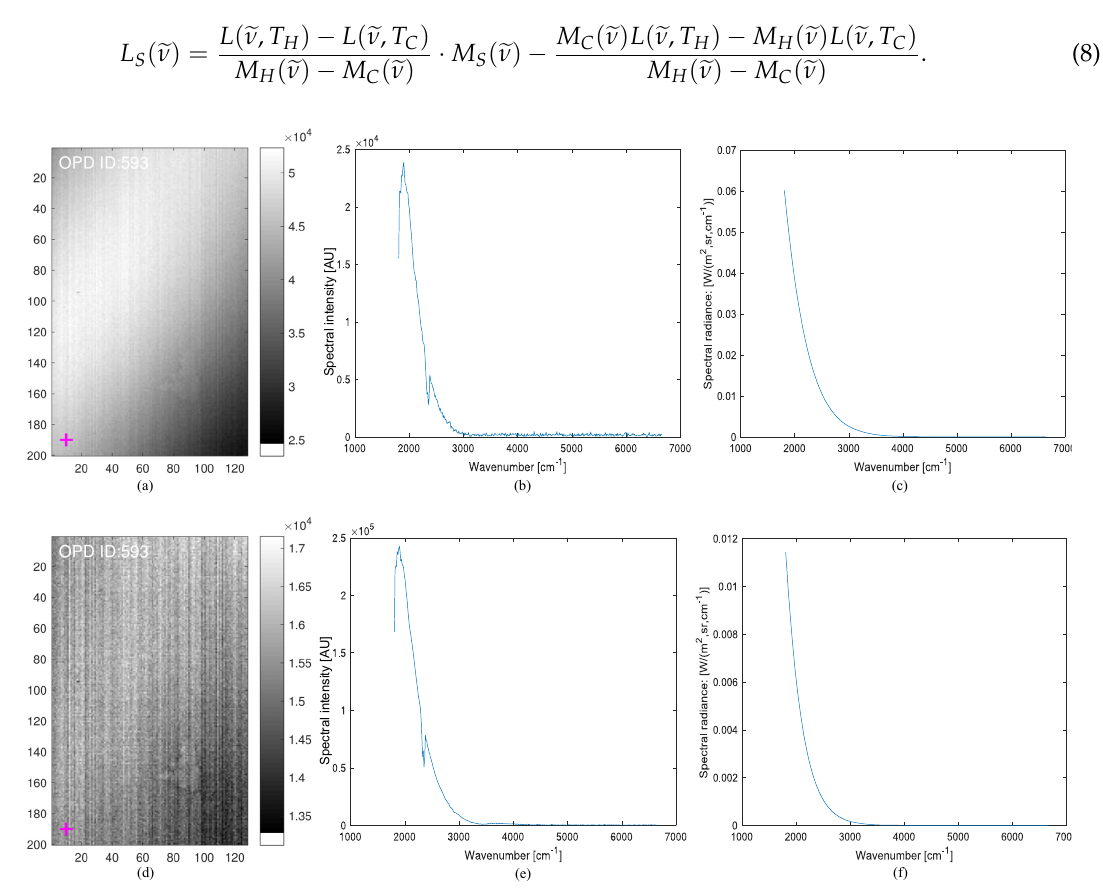
Figure 4. Blackbody spectrum and spectral radiance extraction for a radiometric calibration: ( a ) interferogram image of a hot blackbody (95 ◦ C); ( b ) spectrum of a hot blackbody; ( c ) calculated spectral radiance at hot temperature; ( d ) interferogram image of a cold blackbody (25 ◦ C); ( e ) spectrum of a cold blackbody; ( f ) calculated spectral radiance at cold